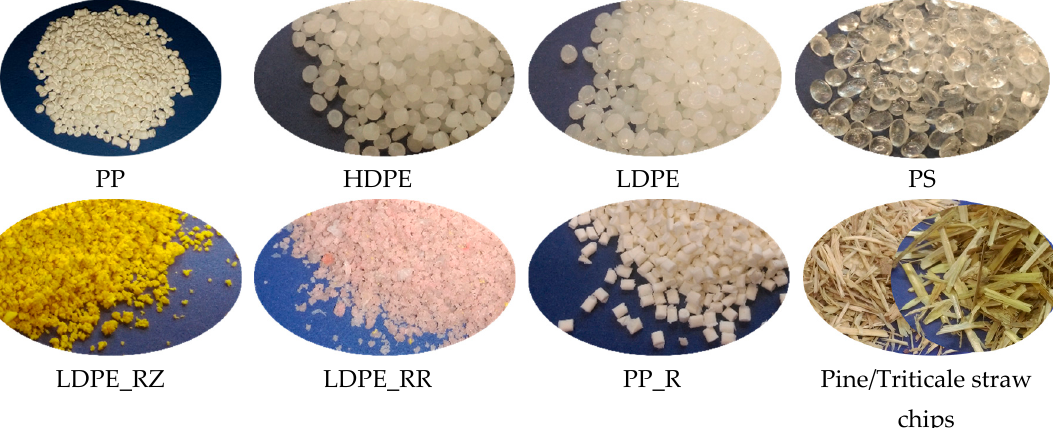
Figure 1. The photographs of the fillers.